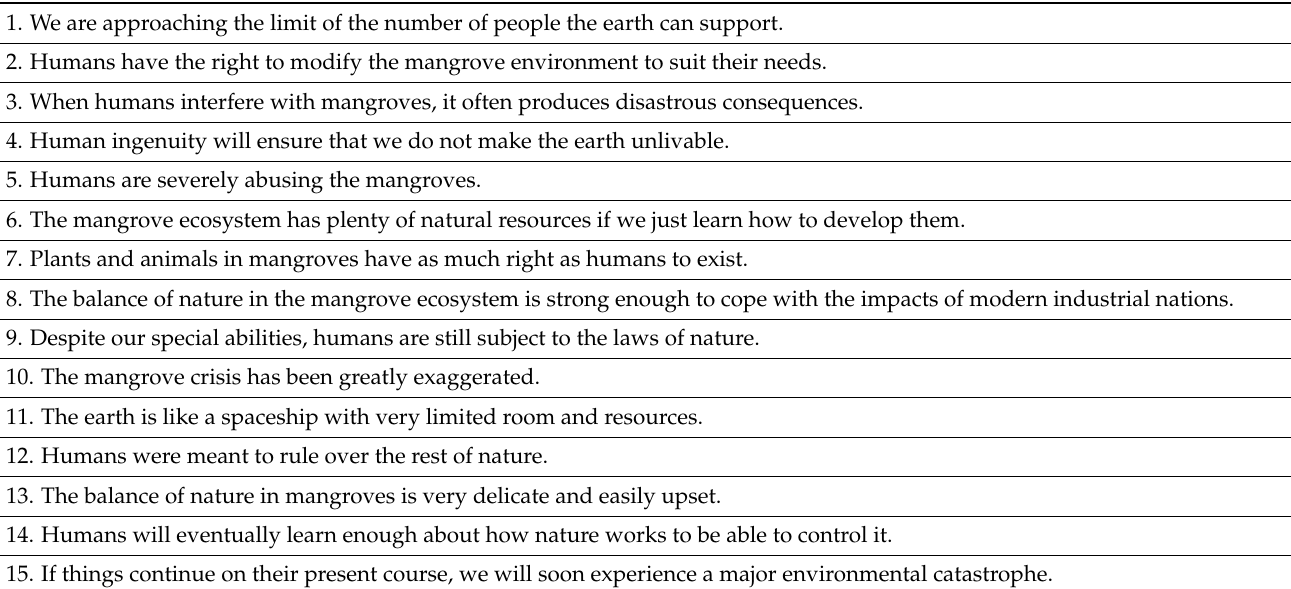
Figure 2. Guided visit to the local mangrove site.